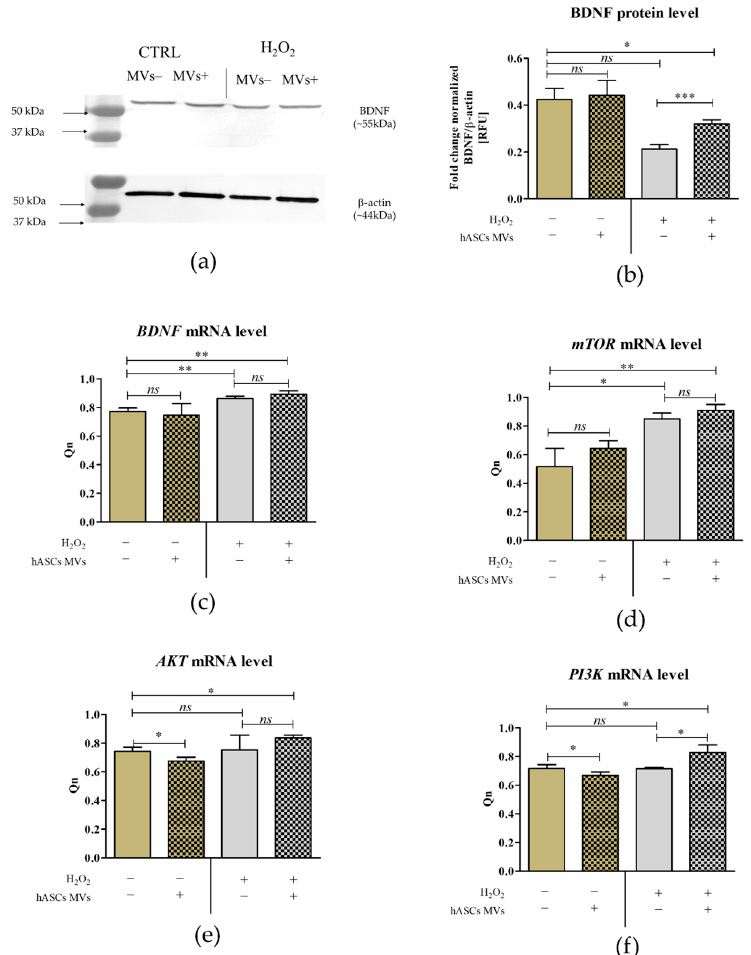
Figure 7. The influence of MVs on the expression of brain derived neurotrophic factor (BDNF) and elements of PI3K/Akt/mTOR signaling pathway. BDNF accumulation in cells was determined using the Western blot technique ( a ). The densitometry analysis was performed using ImageLab software, the amount of accumulated protein was determined in relation to the β -actin ( b ). The mRNA levels for BDNF ( c ), mTOR ( d ) AKT ( e ) and PI3K ( f ) were established using RT-qPCR, and quantitative analysis was performed in reference to GAPDH . The obtained results i.e. normalized values (Qn) were tested using statistical methods. An asterisk marks statistically significant differences (* p ≤ 0.05, ** p ≤ 0.01and *** p ≤ 0.001) and differences between healthy cultures and cultures with induced oxidative stress are marked in red font. The results are expressed as mean ± S.D.